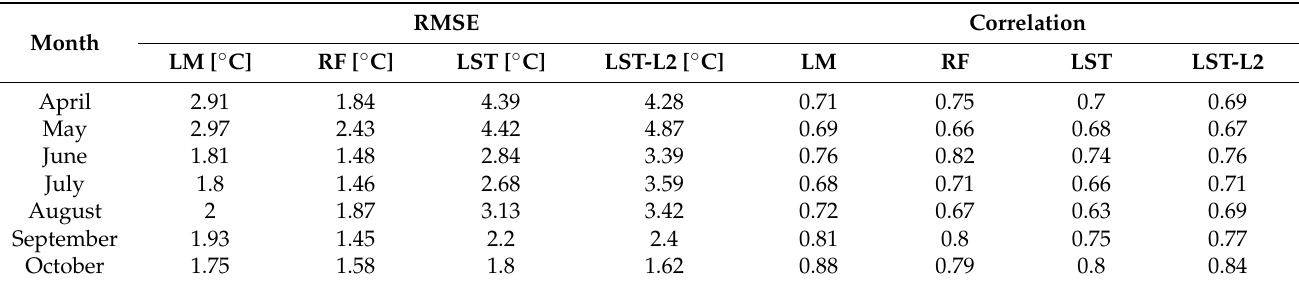
Table 2. Model performance per month on a test set. Note that the month index was used as a predictor in the random forest model.